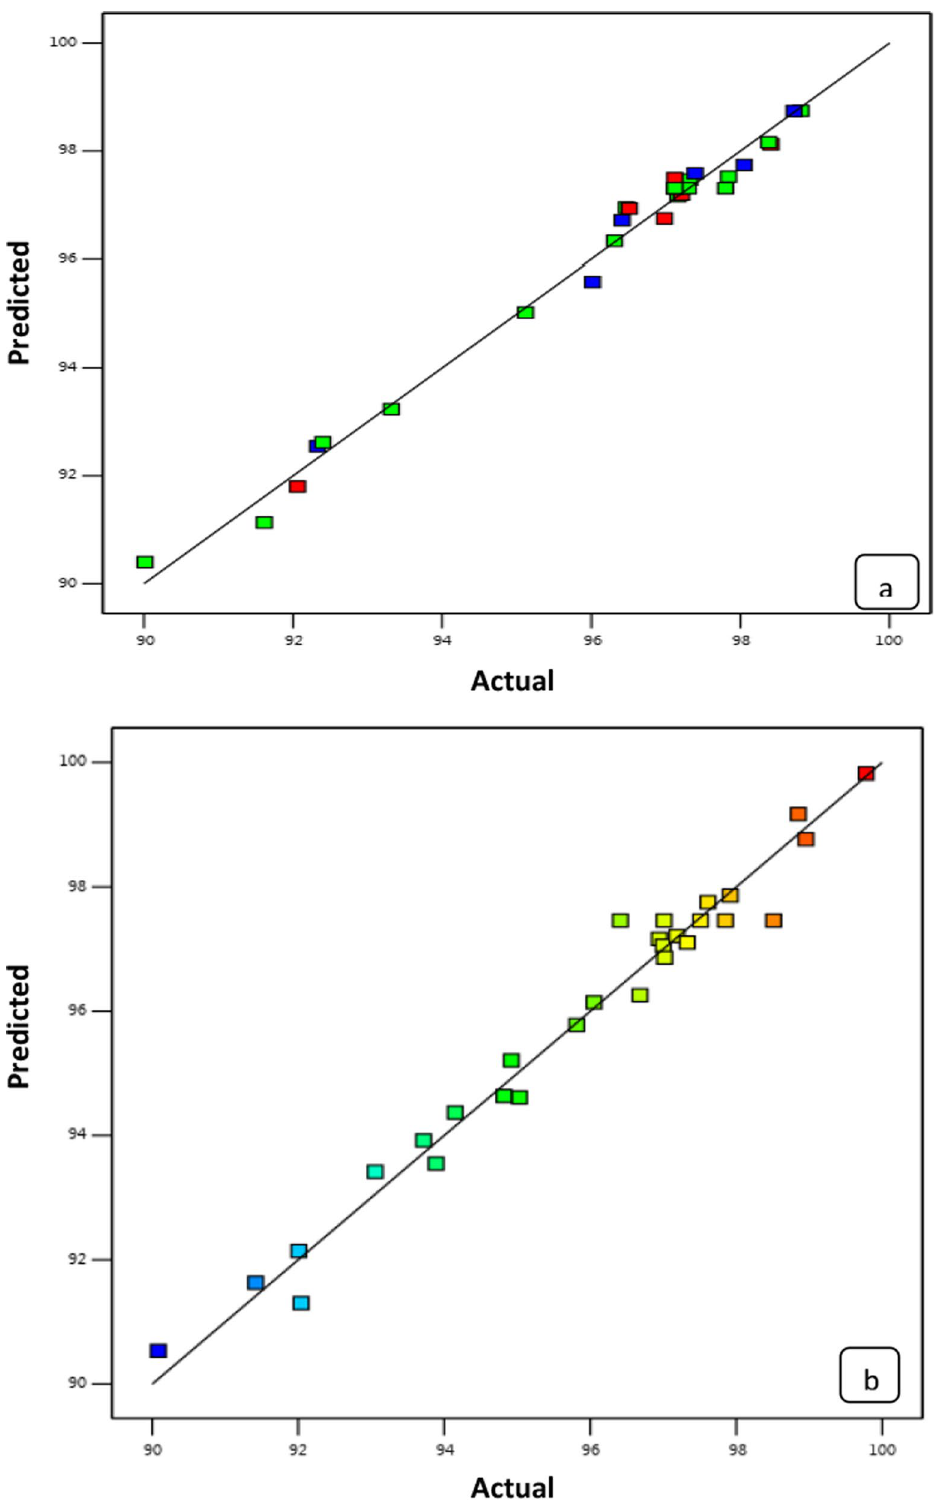
Fig. 11 Linear correlation between experimental and predicted removal efficiency % MG by a nano-bentonite and b MgO impregnated